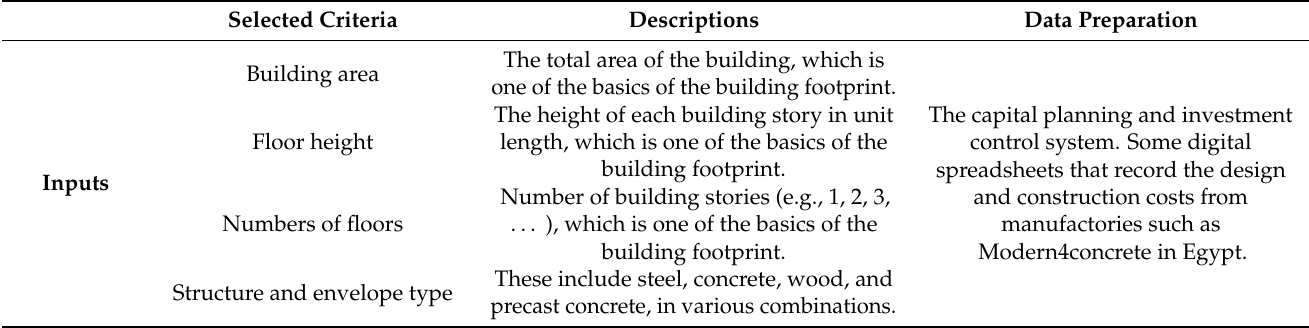
Table 2. Description and preparation of input and output criteria related to building life cycle